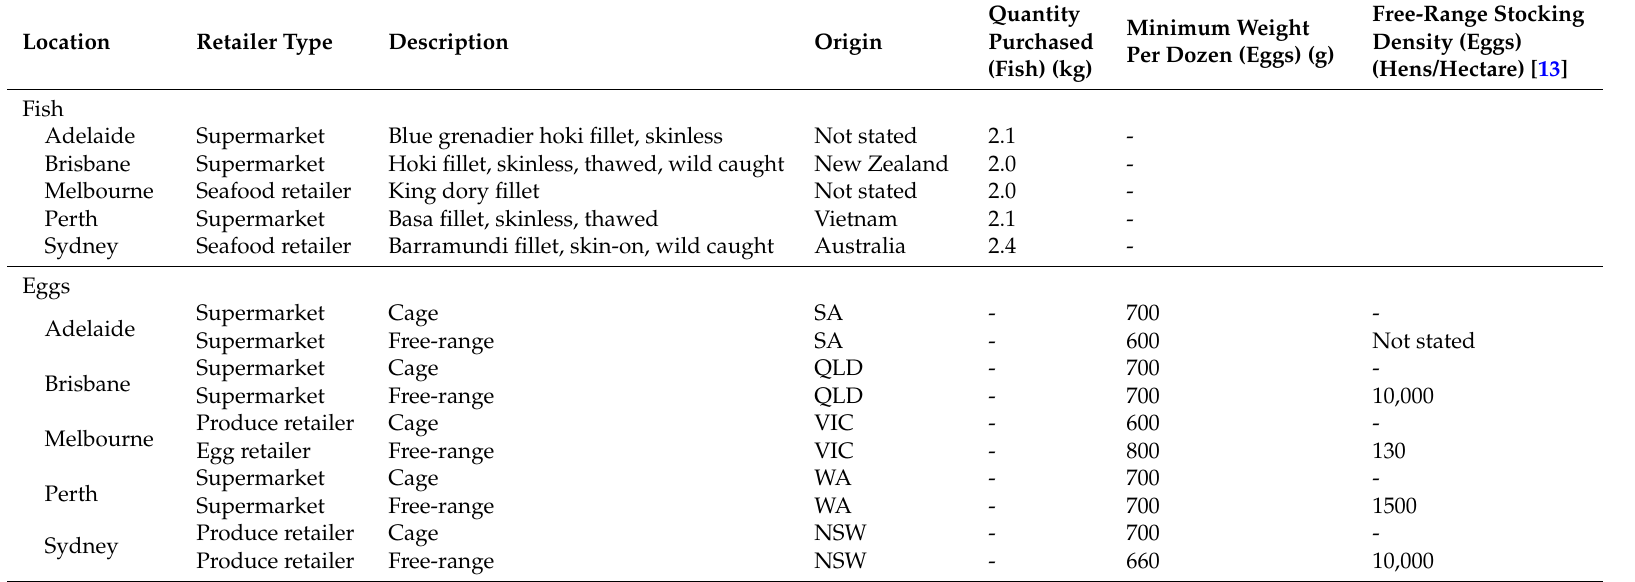
Table 1. Retail sources and characteristics of white fish and eggs purchased in Australia for analysis of vitamin D 3 and 25-hydroxyvitamin D 3 .